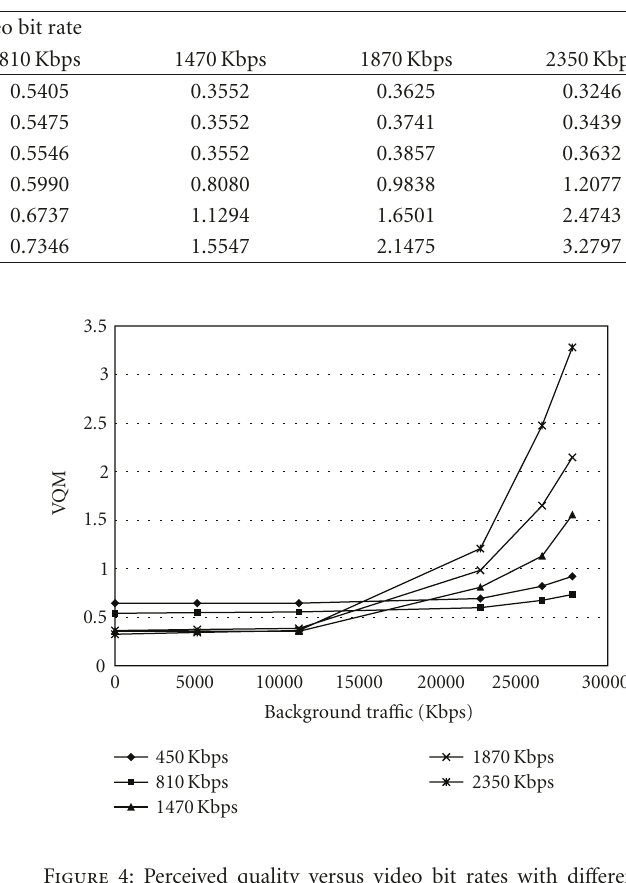
Figure 4: Perceived quality versus video bit rates with di ff erent background tra ffi